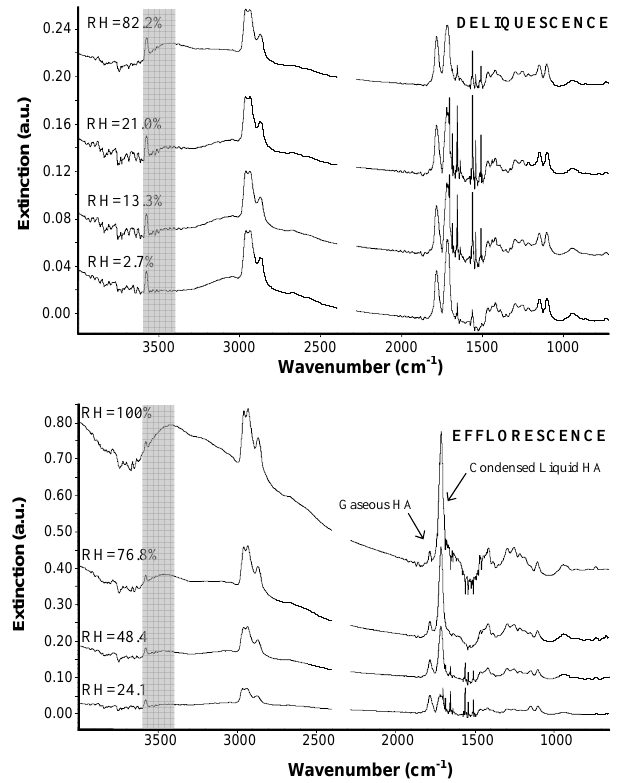
Figure 6. Spectra showing the evolution of the infrared absorp- tion intensity of the C=O band of hexanoic acid near 1700cm − 1 with RH in NaBr particles in deliquescence and efflorescence mode. Also the shaded region indicates the selected area for measuring liquid-water abundance in the particles (see